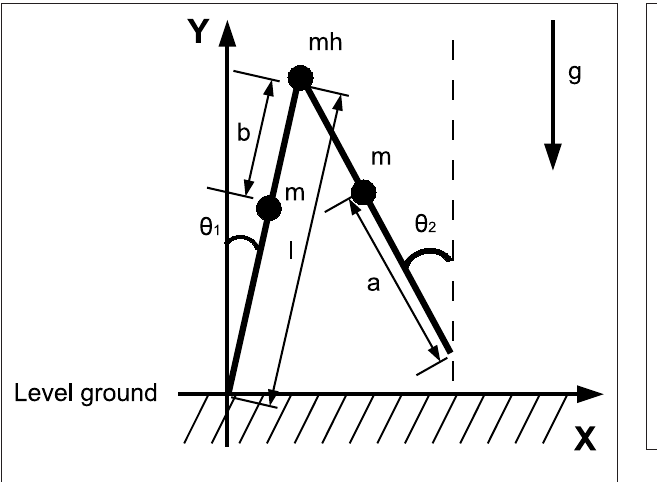
FIGURE 15 | Model of the compass-gait biped.